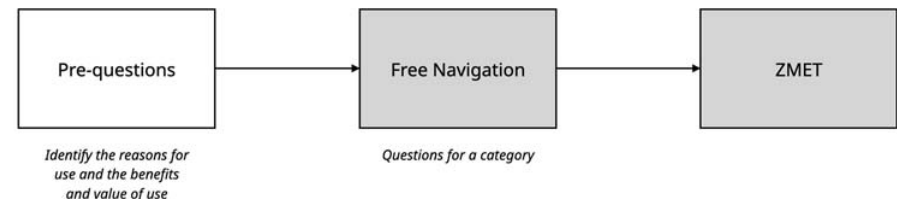
Figure 2. Study 1 Procedure.